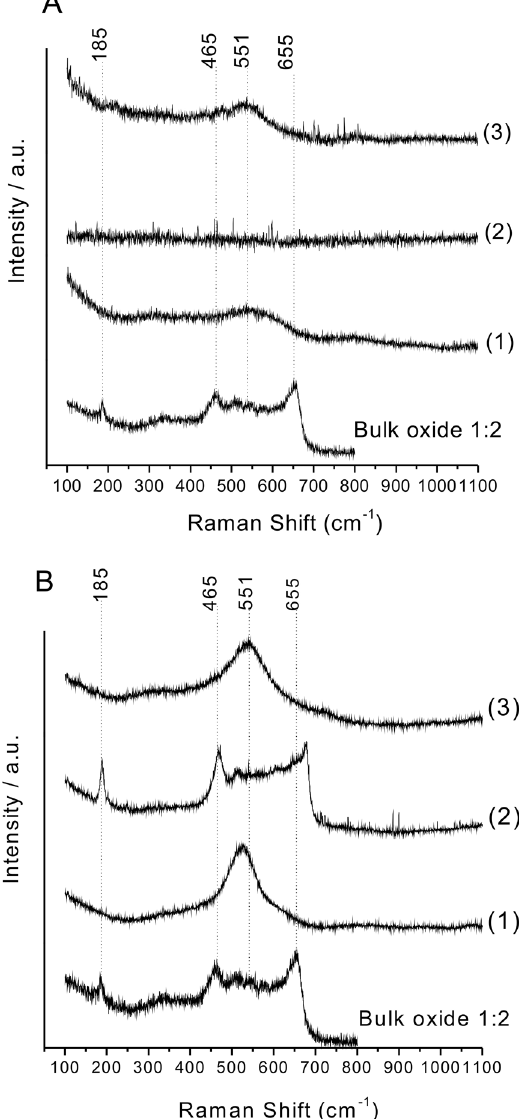
Figure 2. Raman spectra of the coatings obtained using Solution 1 (A) and Solution 2 (B) under the conditions described in Table 1: (1) Experiment 1; (2) Experiment 2; (3) Experiment